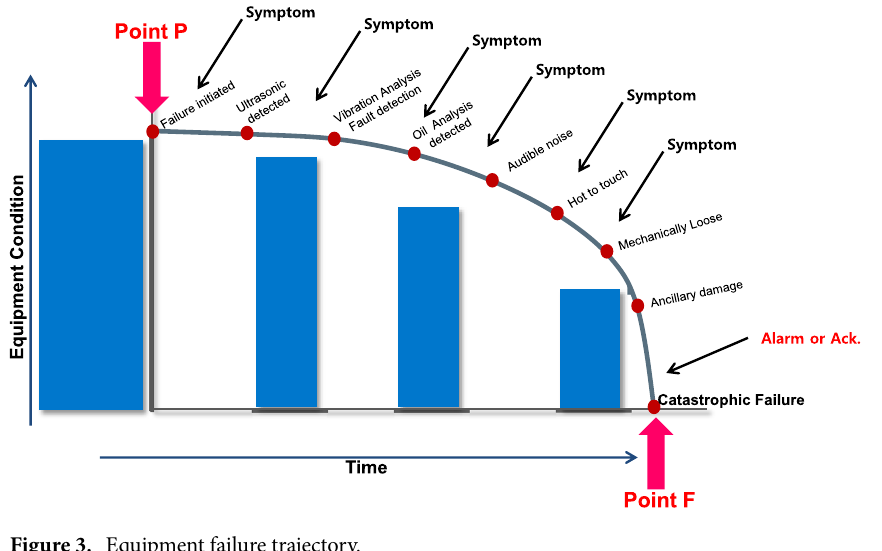
Figure 3. Equipment failure